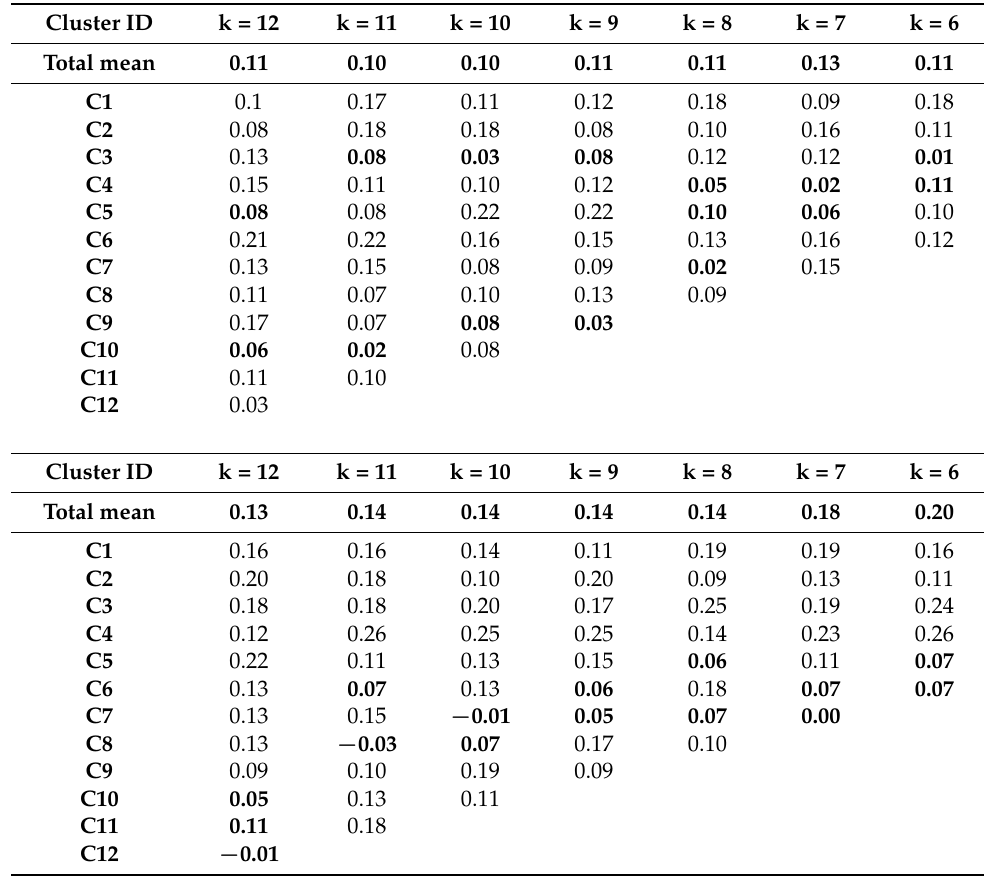
Table 2. Silhouette indices for R z (510) (top) and R z (620) (below) for different values of k. The clusters located in the Gulf of Riga, on the eastern coast of the Gotland Basin and occasionally on the Gulf of Finland are